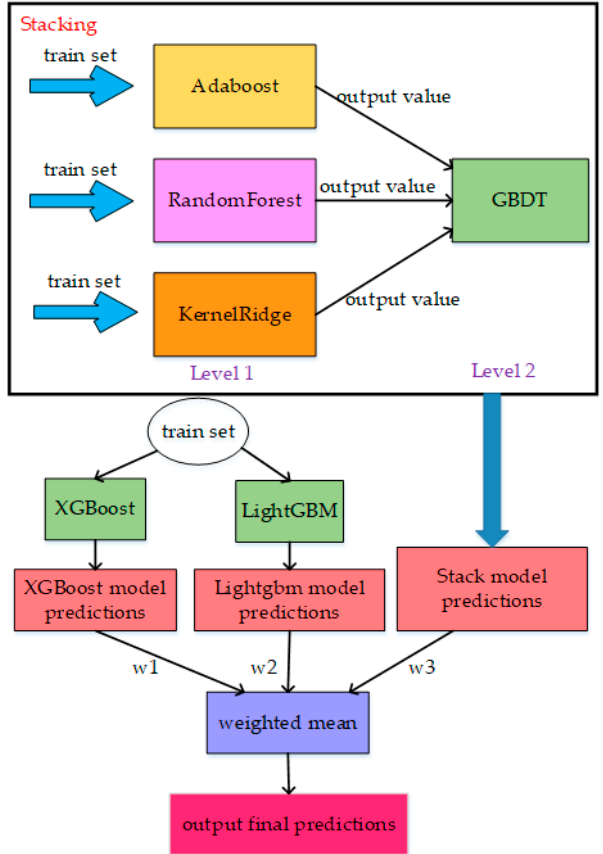
Figure 8. The overall framework of the tree-fusion-based regression